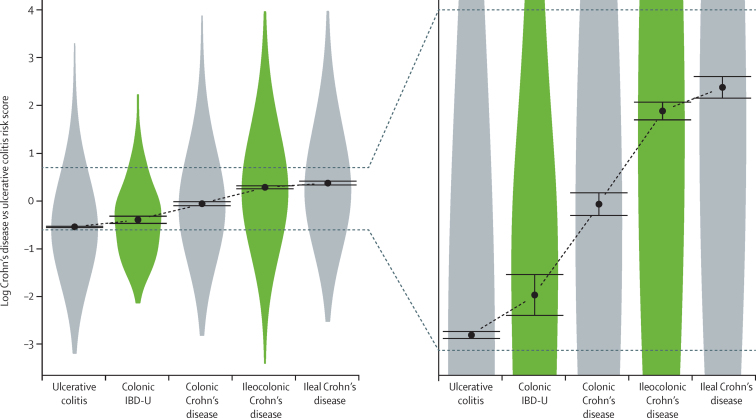
Violin plot showing the genetic substructure of inflammatory bowel disease locationThe violin represents the range of the log CD versus UC score for the indicated subphenotype (calculated with the R package “vioplot”), with dots representing the mean of that group and error bars the 95% CIs. Although the effects are small compared with the variation within groups, the mean effects can still be measured accurately (right side of the figure). It can be seen on this figure that the Crohn's disease versus ulcerative colitis (CD vs UC) risk score placed colonic Crohn's disease between ileal Crohn's disease and ulcerative colitis. The plot also shows the positioning of the intermediate phenotypes (ileocolonic Crohn's disease and inflammatory bowel disease unclassified [IBD-U]) in between ileal and colonic Crohn's disease, and ulcerative colitis and colonic Crohn's disease, respectively.